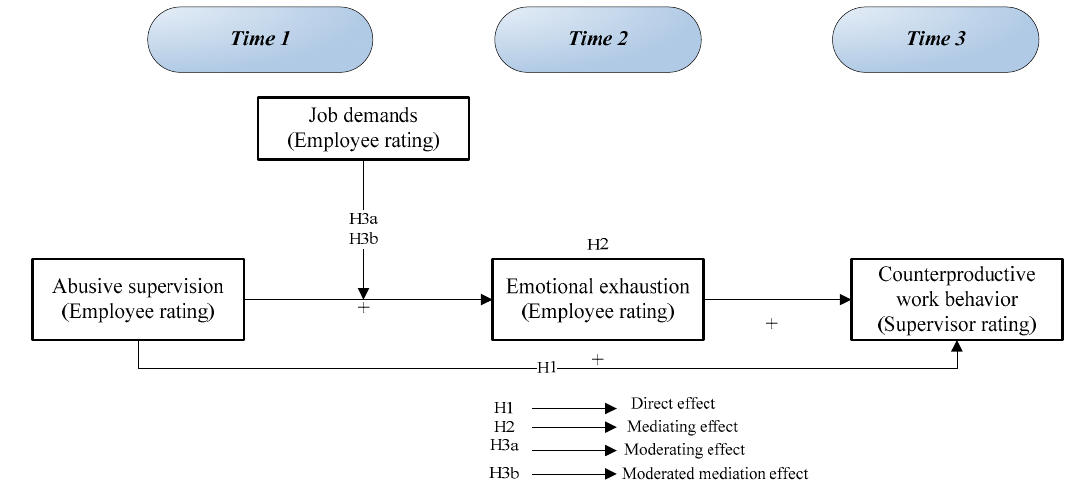
Figure 1. A moderated-mediation model.